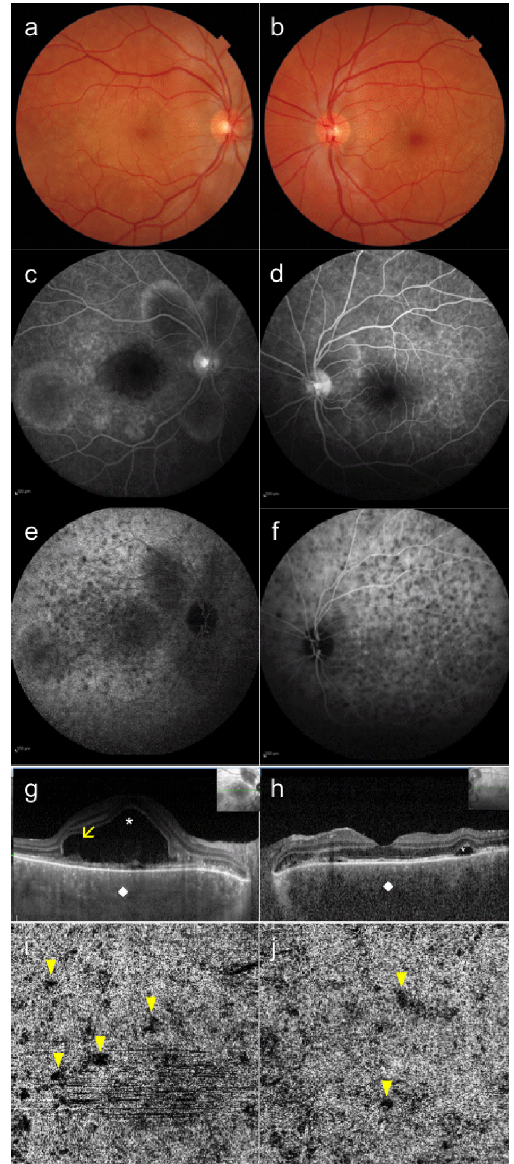
Figure 1: Multimodal retinal imaging of Vogt-Koyanagi-Harada Figure 2: Multimodal non-invasive retinal imaging of disease of both eyes at presentation. (a, b) Color fundus Vogt-Koyanagi-Harada disease of both eyes 3 months after photograph shows multifocal subretinal detachments (SRD) presentation. (a, b) Color fundus photograph shows resolution involving the posterior pole of the right eye and the peripapillary of the multifocal subretinal detachments in both eyes. area of both eyes. (c, d) Fluorescein angiography late frames (c, d) Fluorescein angiography shows residual mild retinal show areas of pinpoint hyperfluorescent leaks of the retinal pigment epithelium changes in both eyes. (e, f) Indocyanine pigment epithelium with multifocal dye pooling underneath green angiography (ICGA) frames show remarkable decrease the SRD. (e, f) Indocyanine green angiography (ICGA) frames in size and number of the hypofluorescent lesions visible at show persistent multiple hypofluorescent lesions, better seen presentation. (g, h) Enhanced-depth imaging optical coherence in the late phases of the examination. (g) Enhanced-depth tomography (EDI-OCT) scan of both eyes show regression of imaging optical coherence tomography (EDI-OCT) scan of the the increased subfoveal choroidal thickness (538 µm in the right eye shows increased subfoveal choroidal thickness right eye and 548 µm in the left eye) and resolution of (712 µm, white rhombus) and a bacillary detachment (white asterisk) associated with fibrin-like subretinal hyperreflective material (yellow arrow). (h) EDI-OCT of the left eye shows increased subfoveal choroidal thickness (750 µm, white rhombus) and extrafoveal subretinal accumulation of fluid (white asterisk). (i, j) OCT angiography of the choriocapillaris (4.5x4.5 mm) of both eyes shows multiple flow void spots (yellow arrowheads) at the posterior pole that correlate with the hypofluorescent lesions detected on ICGA.